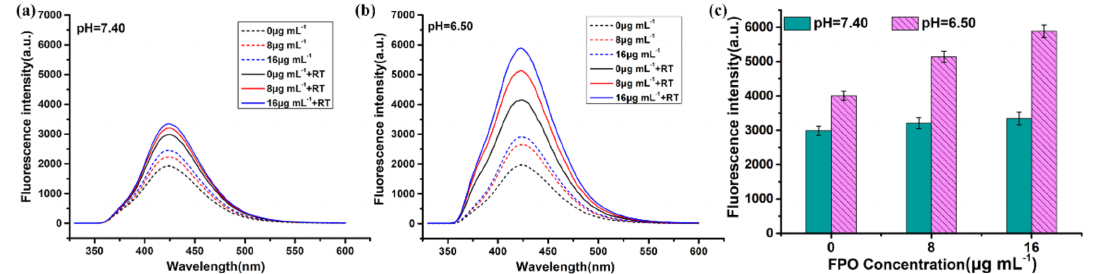
Figure 6. Fluorescence assay of FPO@HMSNs-PAA (the FPO concentration of 0, 8, and 16 µ g mL − 1 ) with same RT intensity (55 kV, 6 mA) in different PBS solution of ( a ) pH 7.40 and ( b ) pH 6.50. FPO@HMSNs-PAA at pH 6.50 showed stronger fluorescence intensity than that at pH 7.40. ( c ) Comparison of fluorescence intensity about pH 7.40 and pH 6.50 (55 kV, 6 mA).